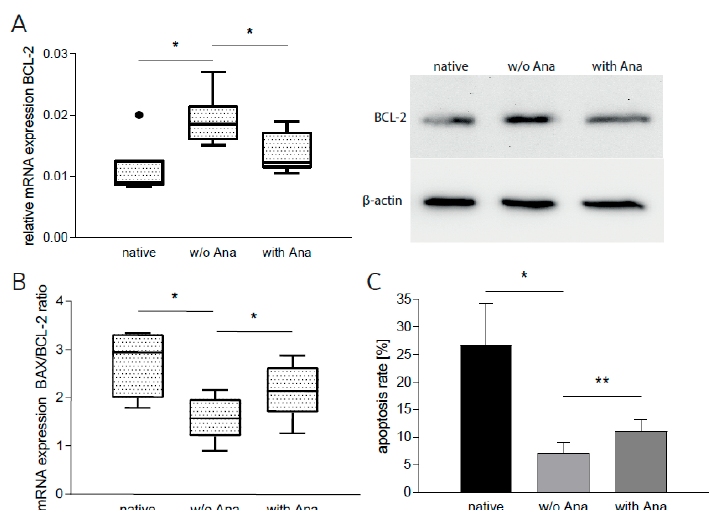
Figure 4. Anakinra increased apoptosis in GBM cells. T98G cells were incubated in conditioned media from direct GBM–PBMC co-cultures with or without (w/o) anakinra (Ana). ( A ) mRNA and protein expression of BCL-2 in T98G (n = 7, p < 0.035). One representative example of sodium dodecyl sulfate polyacrylamide gel electrophoresis is shown. ( B ) BAX and BCL-2 mRNA expression in T98G were quantified in qRT-PCR and the BAX / BCL-2 ratio was calculated (n = 3, p < 0.05). ( C ) Percentage of apoptotic T98G cells as measured by flow cytometry (n = 7, p < 0.049). * p < 0.05, ** p <